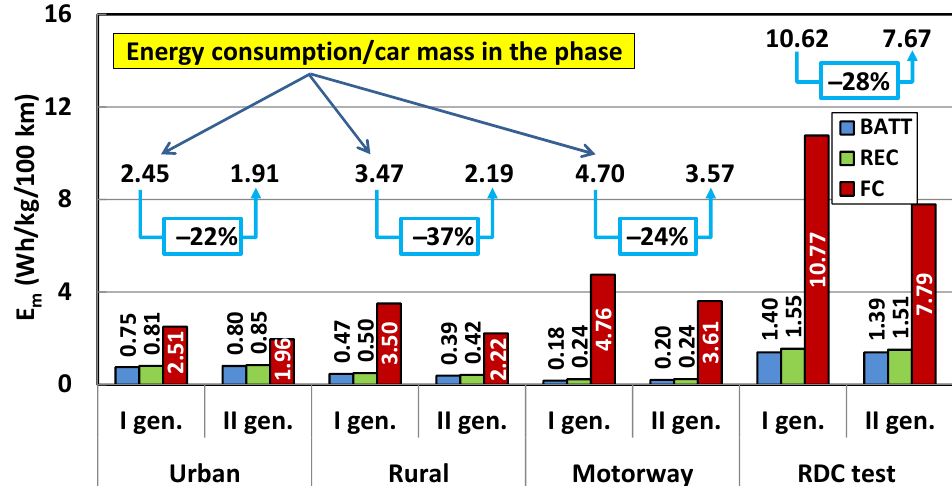
Figure 17. Energy consumption values relative to the vehicle mass determined for both drive generations of the Toyota Mirai in individual test sections as well as for the entire test (the height of the bars correlates to the specific energy from the battery, energy recovered with braking and energy from the fuel cell).